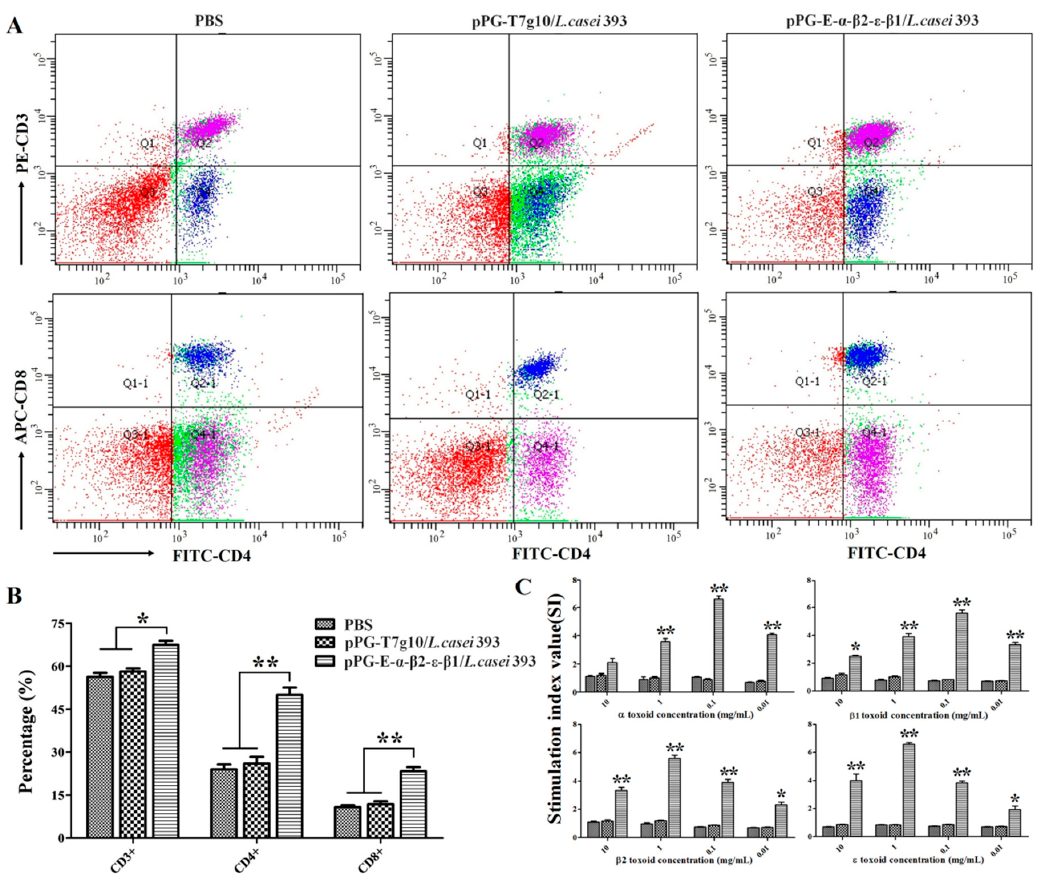
Figure 7. The percentage of CD4 + and CD8 + T cells in rabbit splenic lymphocytes in each group was determined using flow cytometry on day 35 after primary immunization ( A ). Data are presented as mean ± SD in each group ( B ). Moreover, lymphoproliferation was tested after re-stimulation with purified α , β 1, β 2, and ε toxoid proteins, and the results are presented as mean ± SD of each group (* p < 0.05, ** p < 0.01) ( C ).